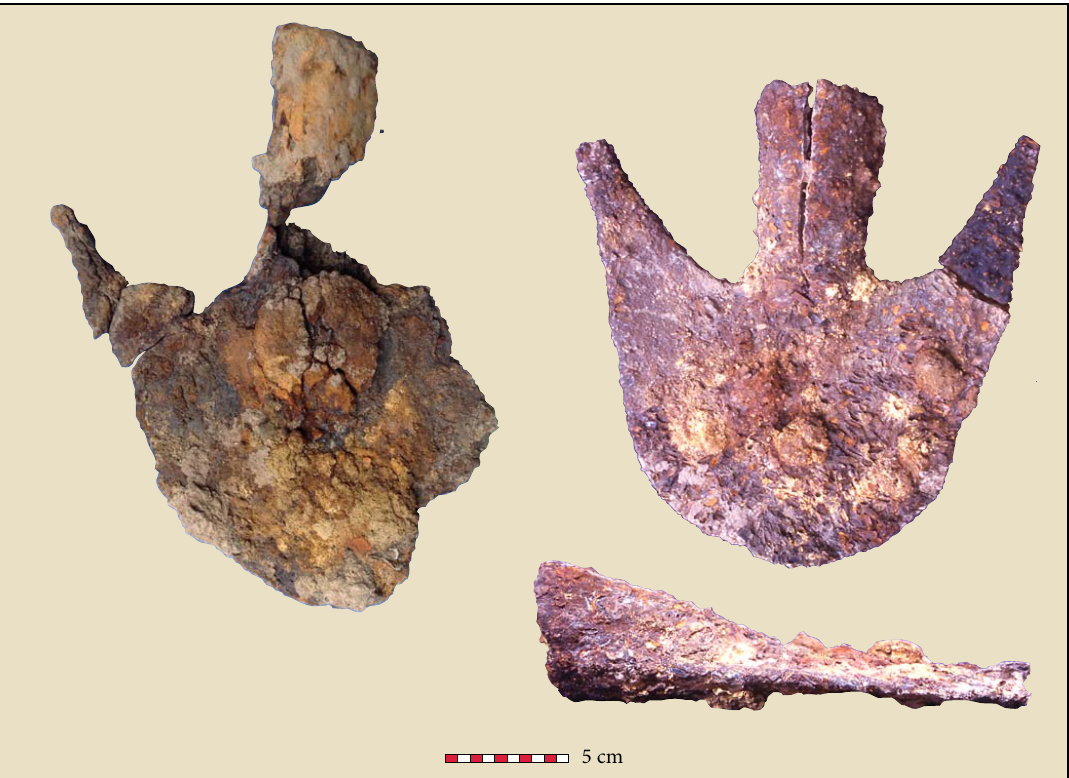
Fig. 10: Iron ploughshares from Non Ban Jak and Noen